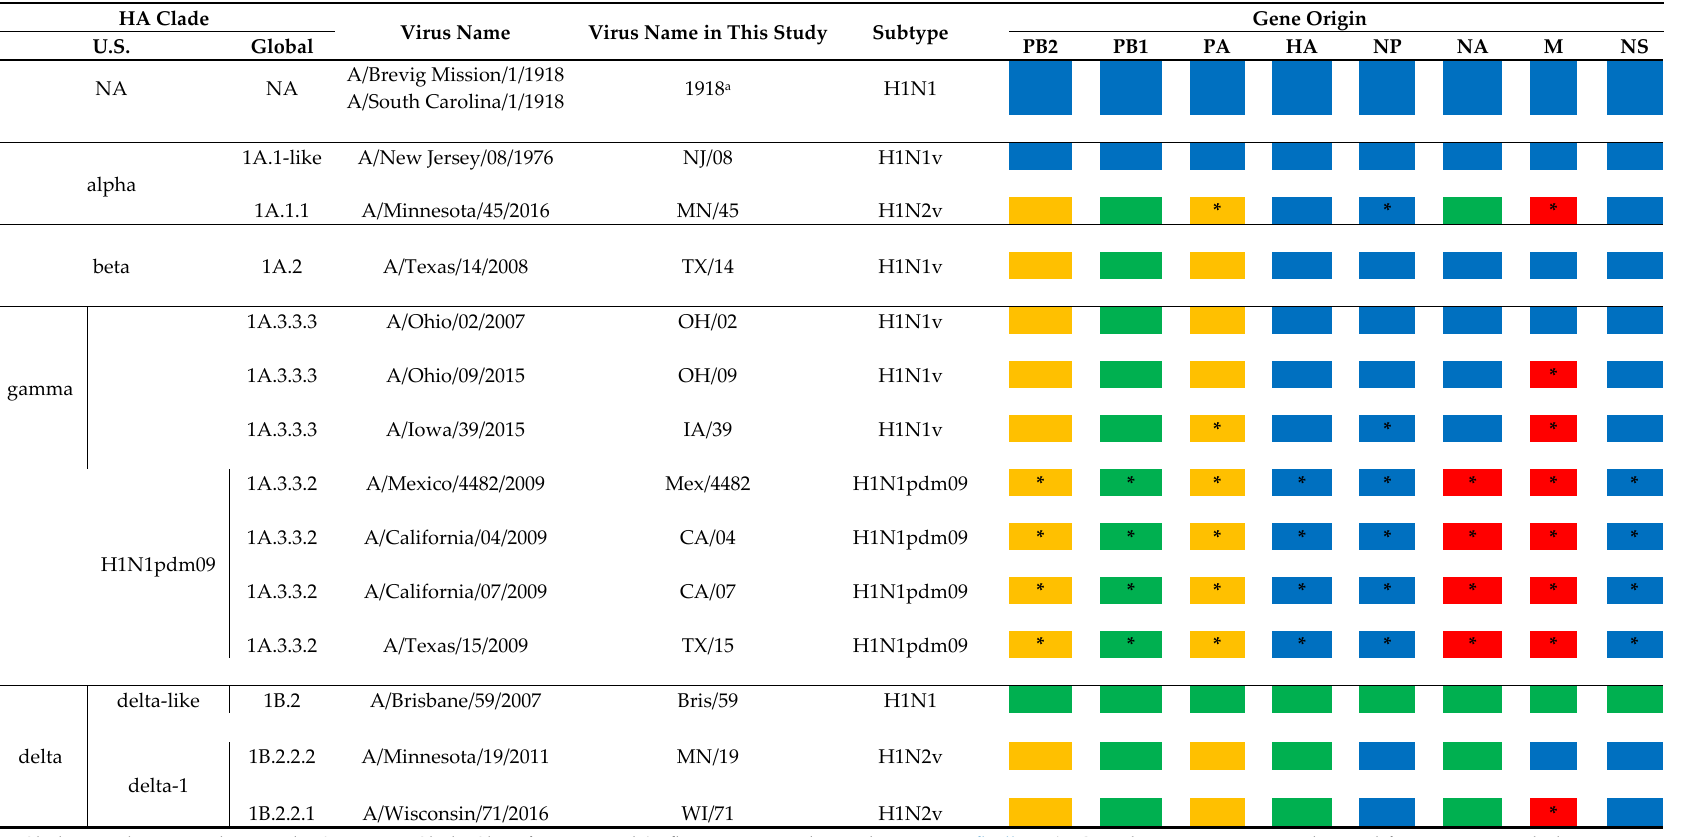
Table 1. Classification and gene origin of representative H1 subtype influenza viruses.